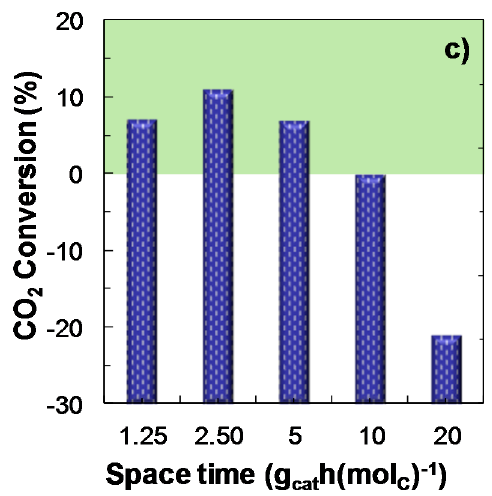
Figure 4. Effect of space time on the conversion of CO x ; ( a ) Product yield; ( b ) CO 2 conversion (or CO 2 yield, for negative values); ( c ) Reaction conditions: Feed, H 2 + CO + CO 2 with H 2 /CO x molar ratio of 3, and CO 2 /CO molar ratio of 2/3; 275 °C; 30 bar.